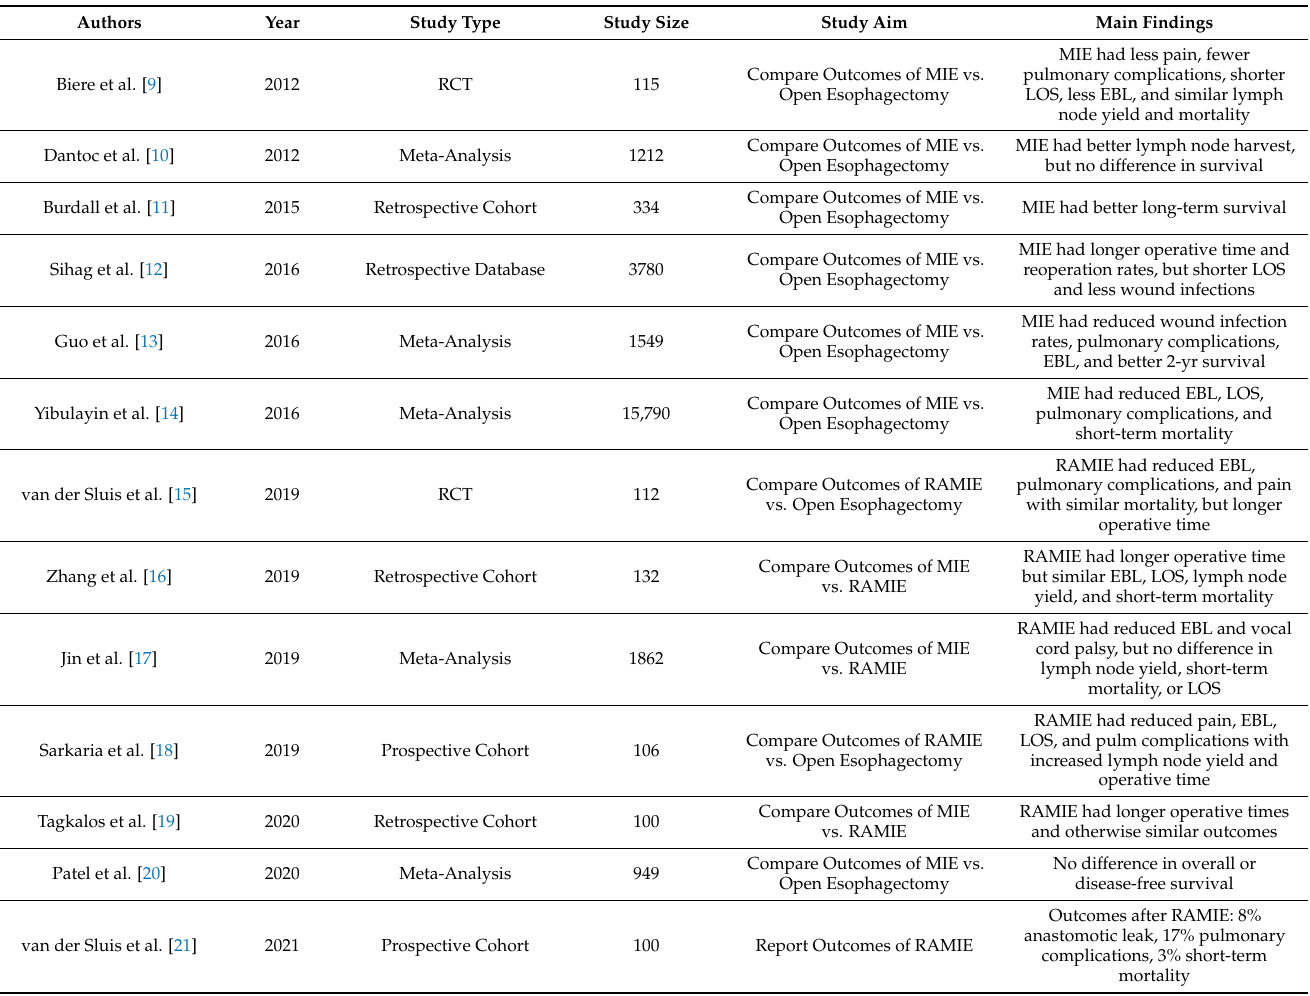
Table 1. Studies included in review of